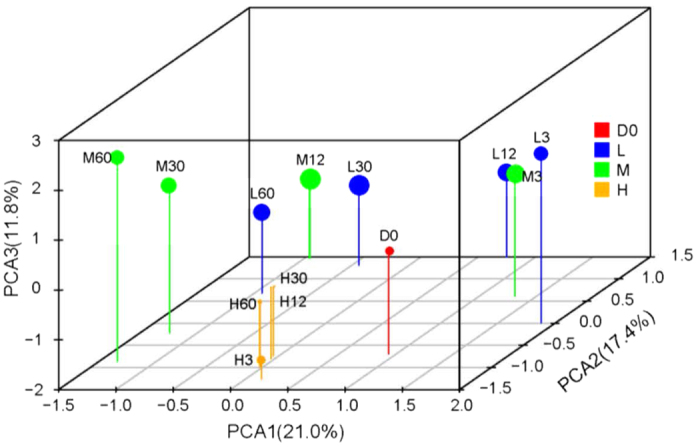
Principal components analysis based on the relative abundances of OTUs during anaerobic digestion at 20 °C (L), 35 °C (M), and 55 °C (H).D0 represents the initial material. The relative size of the circle indicates the number of OTUs.